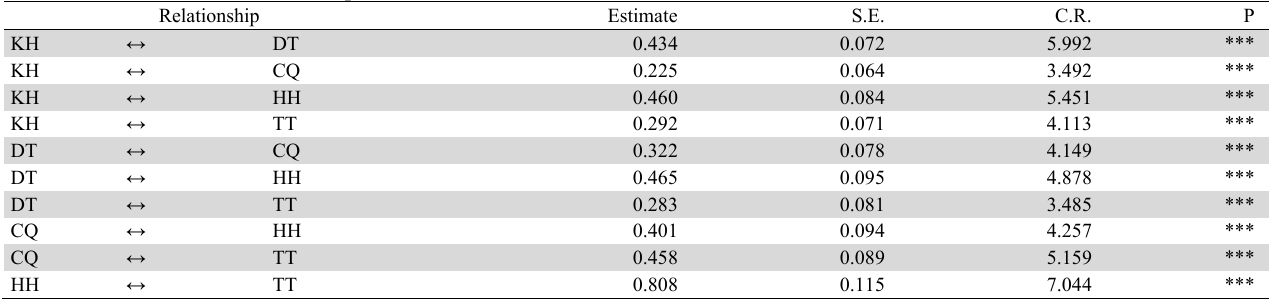
Table 6: Correlation between components of the scale –